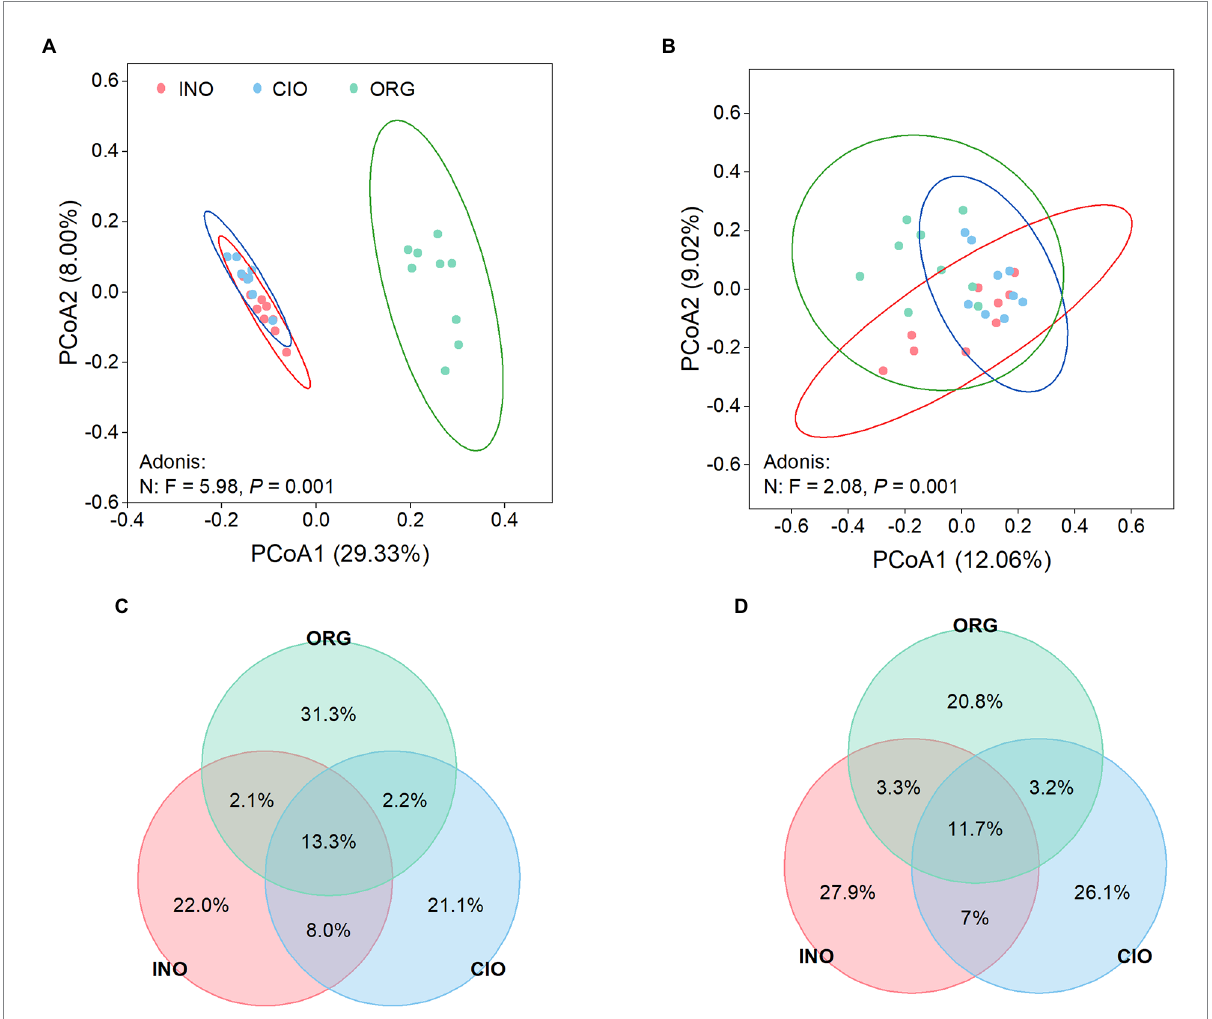
FIGURE 2 Principal coordinate analysis of soil bacteria (A) and soil fungi (B) under three soil N regimes. Venn diagrams depict the percentage of shared and unique ASVs of soil bacteria (C) and soil fungi (D) among three soil N regimes. INO, inorganic N-dominated; CIO, co-dominated by inorganic and organic N; ORG, organic